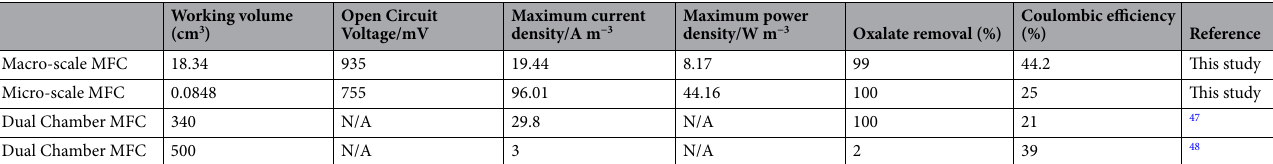
Table 1. The comparison of the overall performance of the